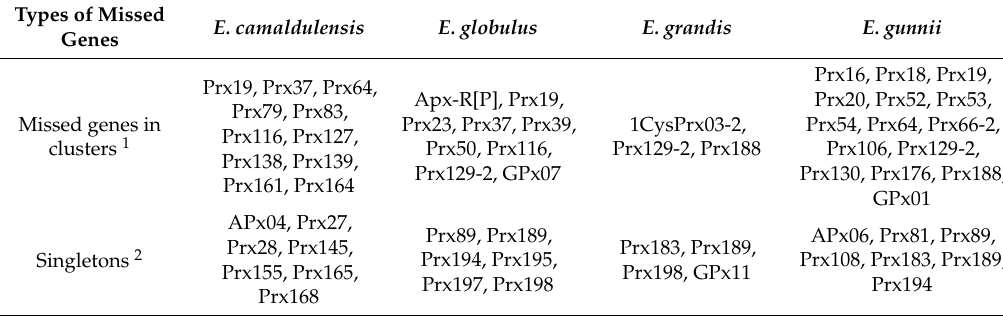
Table 2. Missed sequences from the genomes of the four Eucalyptus